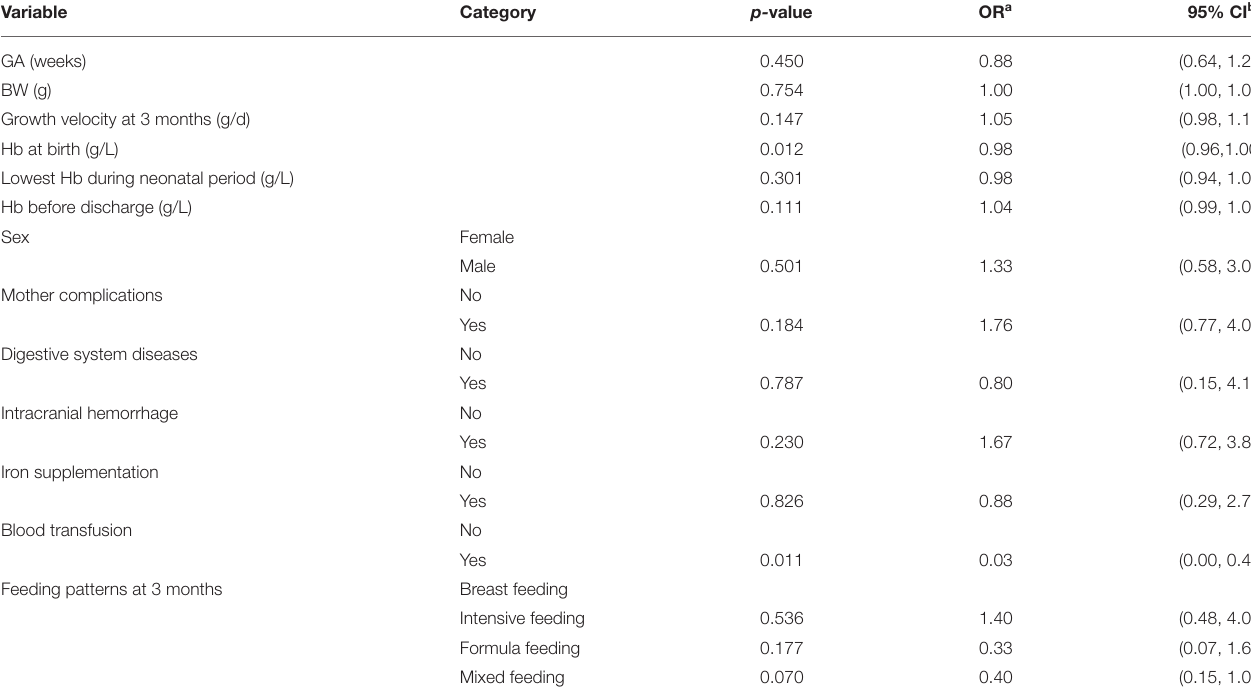
TABLE 4 | Factors relating to ID/IDA at 3